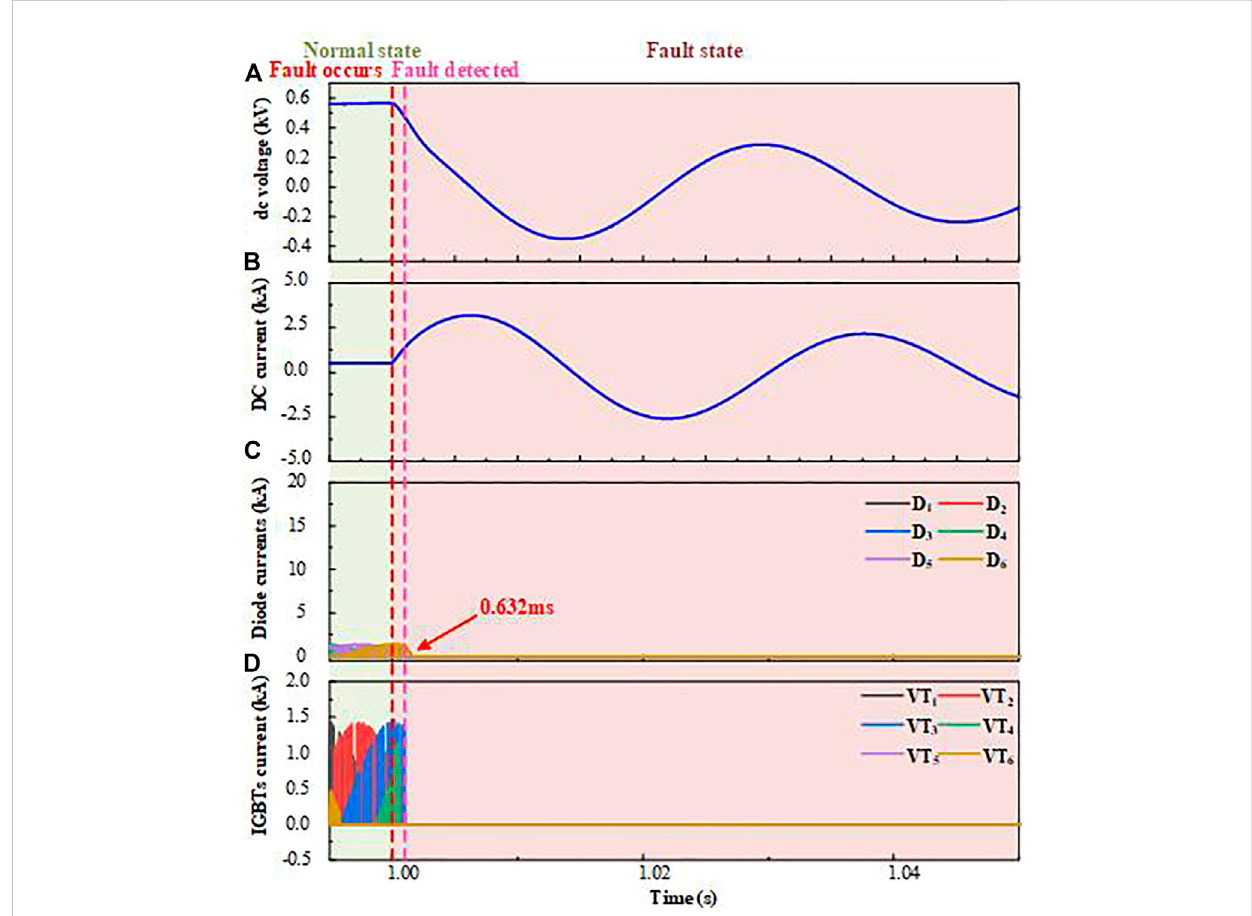
FIGURE 12 Simulation results oftheimprovedVSCduring DCfaultride-through. (A) DC-side voltage; (B) DC-sidecurrent; (C) currents inD 1 ~D 6 and T 1 ~T 3 ;and (D) currents in VT 1 ~VT 6